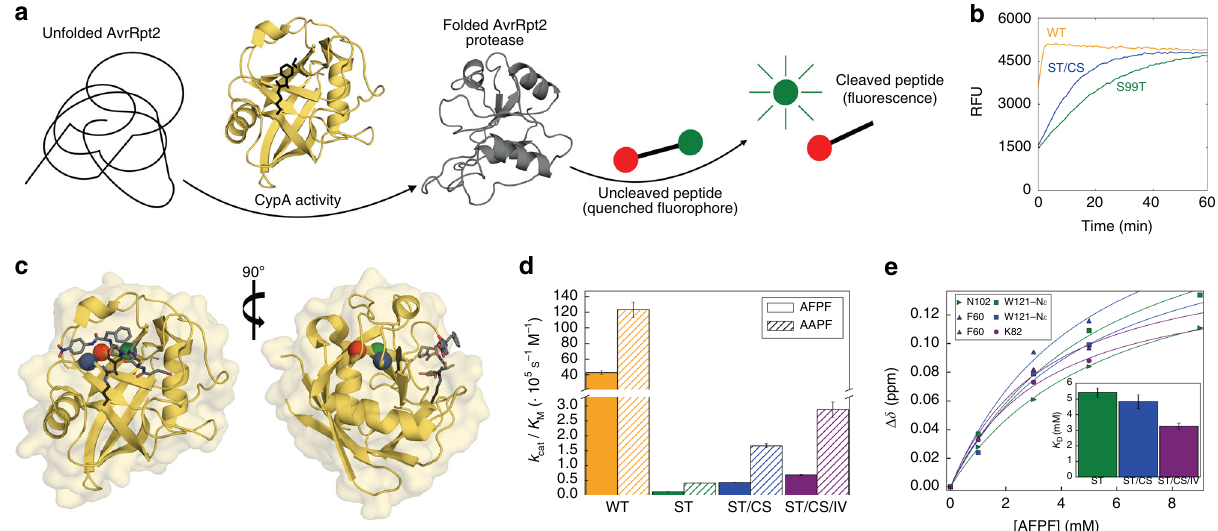
Fig. 1 Directed evolution selects rescue mutations for catalysis. a Scheme of the assay used in directed evolution to identify CypA mutations with increased catalytic activity: CypA activity for folding of AvrRpt2 protease measured by AvrRpt2-mediated cleavage of the peptide Abz-IEAPAFGGWy-NH 2 (y = 3- nitro-Tyrosine). b Assay of directed evolution performed on cell lysate in 96-well plates to identify rescue mutations for S99T with increased CypA activity. Kinetics of peptide cleavage is shown for wild-type (yellow), S99T (green), and S99T/C115S (blue) CypA. c , d The severely catalytically compromised S99T mutant (green) is rescued by second-shell mutations (C115S, blue and I97V, red). c Sites of mutations are plotted onto the crystal structure (1RMH 68 ) of CypA bound to Suc-AAPF-pNA (gray sticks) and the active-site residues Arg55 and Phe113 are shown in black stick representation. The overlay of NMR spectra shows that the overall structure of all CypA forms is very similar, with perturbations observed for residues close to the mutation site or in the dynamic network (Supplementary Fig. 1). d k cat / K M values for wild-type, S99T, S99T/C115S, and S99T/C115S/I97V CypA measured by protease coupled hydrolysis 24 of Suc-AFPF-pNA and Suc-AAPF-pNA peptides (see Table 1). Error bars indicate the standard deviation obtained from triplicate measurements on at least three different enzyme concentrations. e K D values for the three mutant forms of CypA for Suc-AFPF-pNA measured by NMR chemical shift analysis from peptide titrations (see also Supplementary Fig. 2 and Table 1). Error bars denote the standard errors in the fi